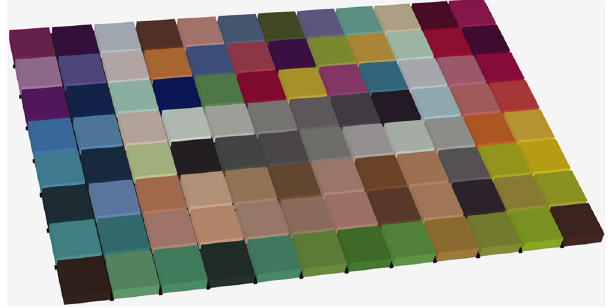
Figure 5. Reconstructed 3D colour chart.